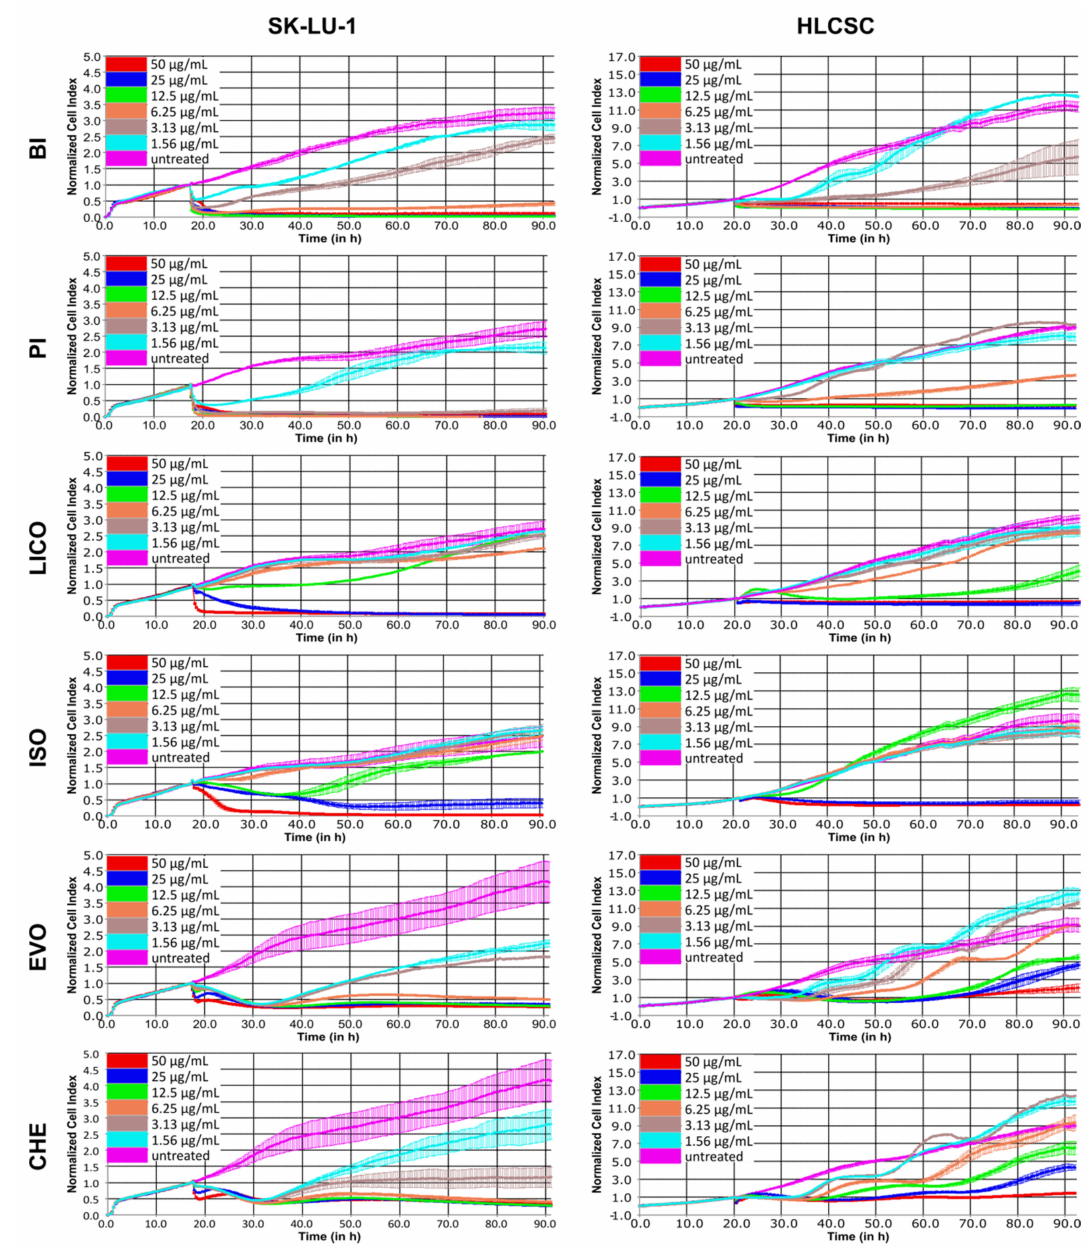
Figure 1. Dose–response curves depicting growth inhibitory kinetics of phytochemicals representatives of alkaloids, chal- cones and isothiocyanates in SK-LU-1 and HLCSC. Various phytochemicals were administered at indicated concentrations after initial overnight growth, and the growth was continuously monitored for at least 72 h post-treatment. Curves presented are representative curves from two independent experiments. Error bars are expressed as mean ± SD from duplicated